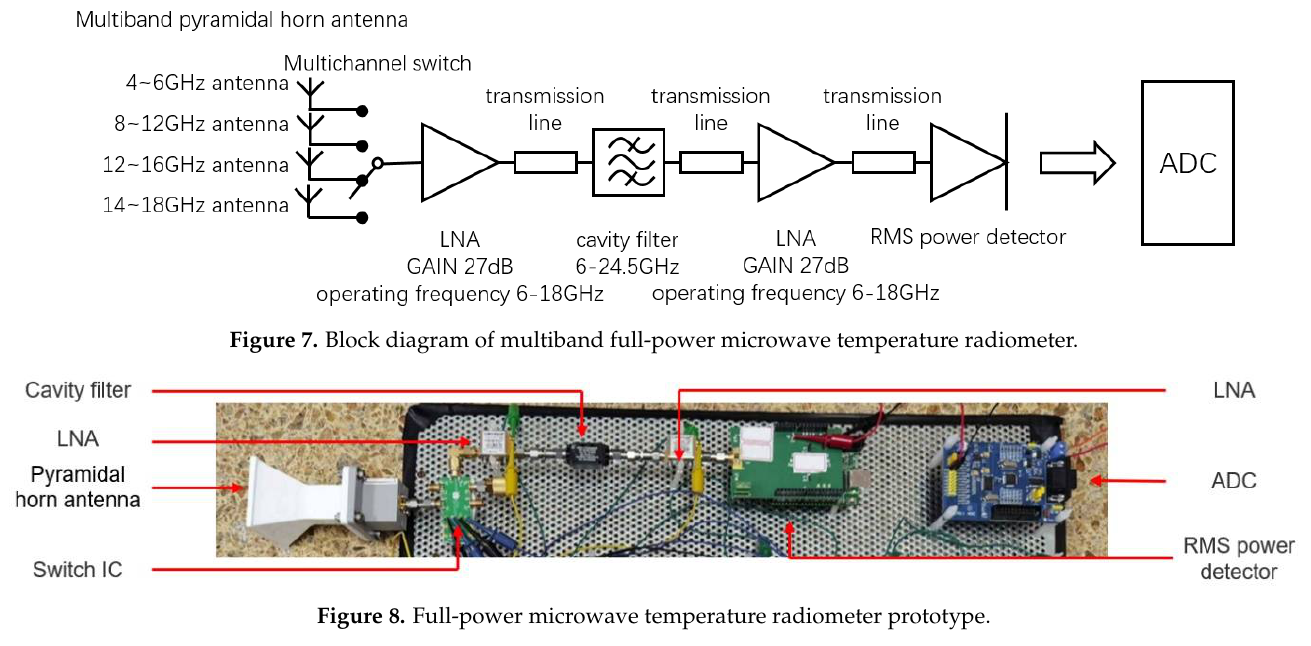
8 of 20 Figure 5. Antenna processing flow chart. (a) 4–6 GHz (d) 14–18 GHz Figure 6. Images of each frequency cone horn antenna. 3.2. Circuit Design of Full-Power Microwave Temperature Measurement Radiometer Previous studies on microwave radiometer temperature measurement mainly adopted a full-power structure. In the existing literature, a full-power radiometer with high sensitivity in a single band was mainly implemented. Therefore, a multiband full-